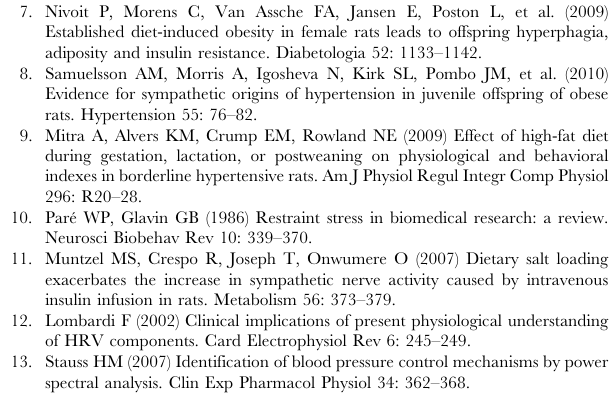
Figure S2 Female offspring of fat-fed dams had a pressor response during acute stress. (A–C) DBP and (D–F) MAP responses during 30 min of acute stress and 120 min of recovery, before (A, D) and after adrenergic receptor blockade (B, E) in female offspring born to dams fed a control (open circles) or a fat diet (closed circles), n =5–15 per group. (C) Area under the